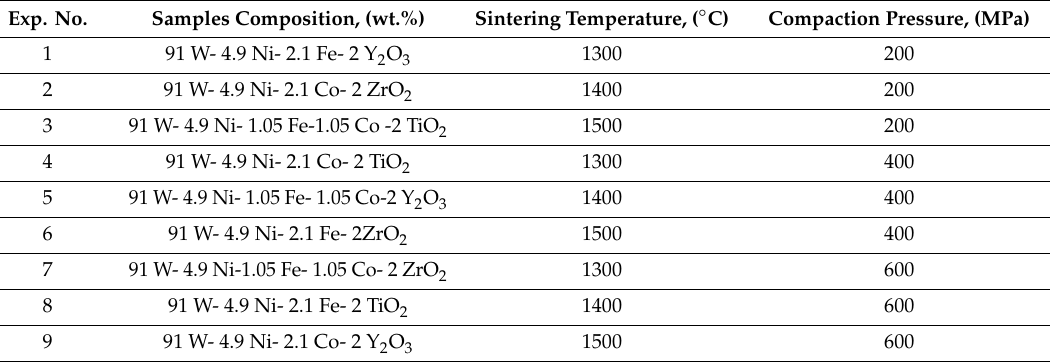
Table 1. The experiment